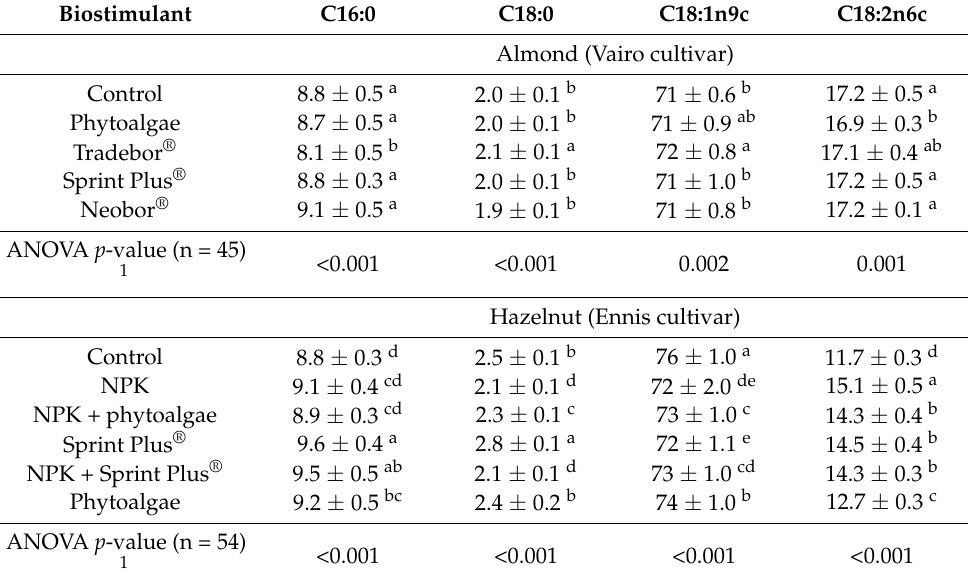
Table 2. Major fatty acids profile (relative%) for almond and hazelnut cultivars submitted to different plant biostimulant